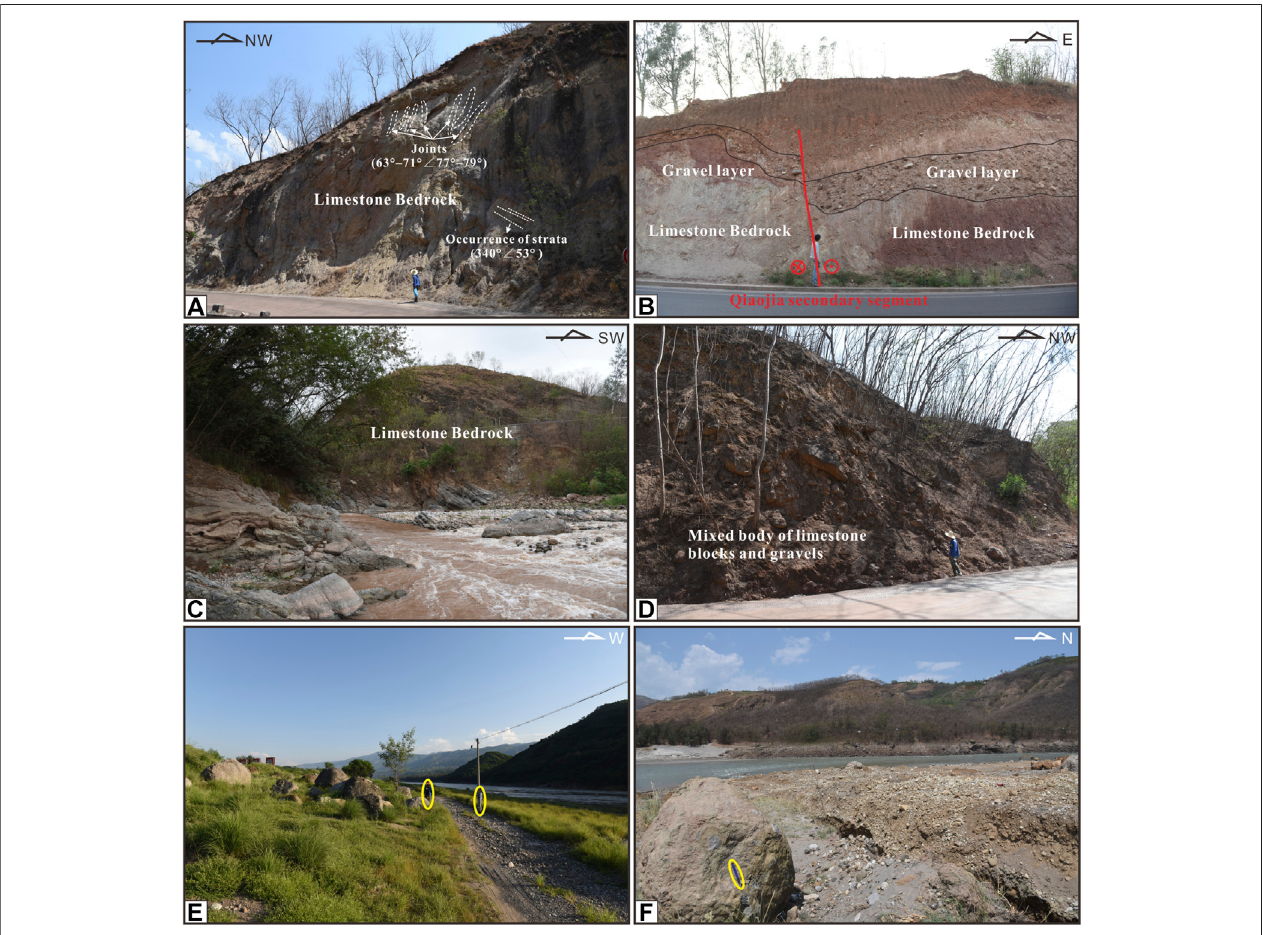
FIGURE 7 | Materials of the Wushenggong Ridge and its adjacent hills. (A) limestone bedrock of the Wushenggong Ridge; (B) terrace gravel layer overlying the limestone bedrock, in the Wushenggong Ridge. The Qiaojia secondary segment can also be seen in this pro fi le; (C) limestone bedrock of the hill north of Wushenggong Ridge; (D) MixedbodyoflimestonebouldersandgravelsofthehillsouthofWushenggongRidge.Alllocationsareillustratedin Figure3 . (E) , (F) Fieldviewsofbouldersat north and south of Lanyingpan, respectively, and person/pencil-outlined for scale. Locations in Figure 7